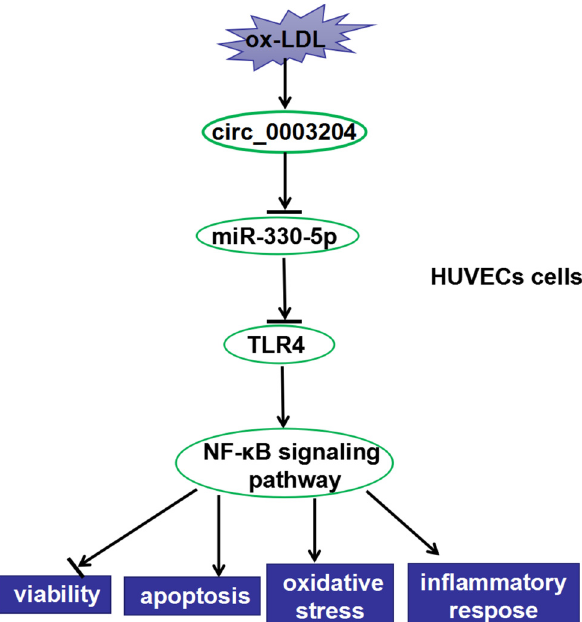
Figure 8: The schematic diagram of the main fi ndings of this research. In ox - LDL - induced HUVECs, circ_0003204 inhibited the viability and promoted the apoptosis, oxidative stress, and in fl am - matory response of cells via mediating the activity of NF - κ B sig - naling pathway by regulating the miR - 330 - 5p/TLR4